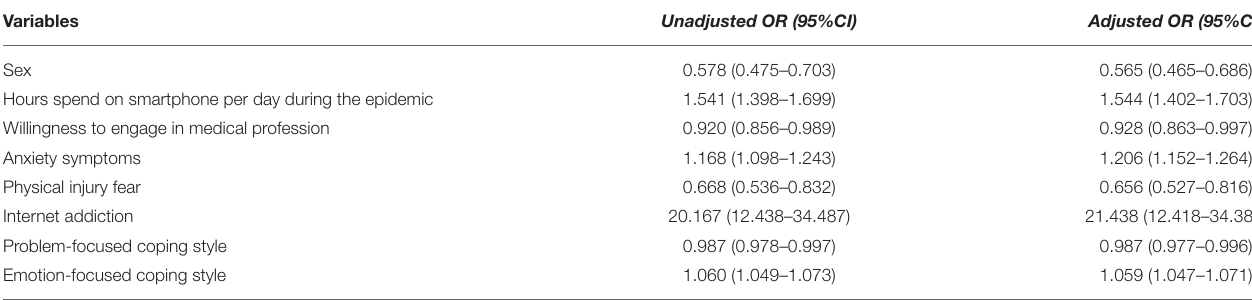
TABLE 4 | Factors associated with the presence of smartphone addiction for respondents during the COVID-19 outbreak ( N =